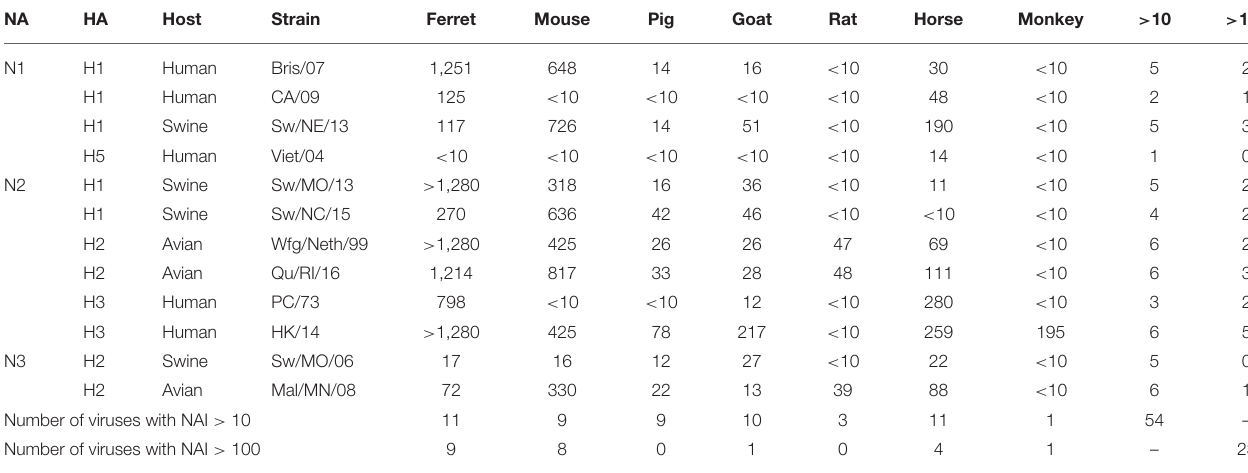
TABLE 3 | NA inhibition of raw sera stratified by host